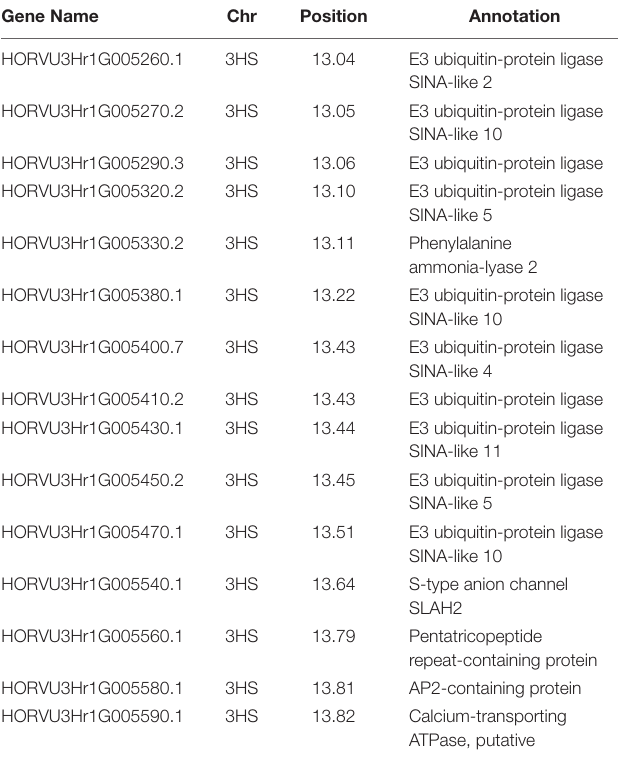
TABLE 2 | The name of the candidate genes identified in relation to salinity tolerance in regards to early root growth, with the chromosome and position on the physical map